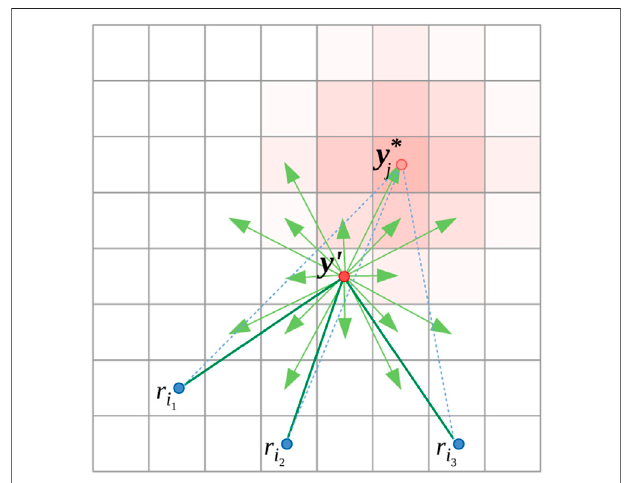
FIGURE 4 | Illustration of control strategy of evader at y ′ . Transition probabilities, K j ( · , y ′ ) are shown in light red